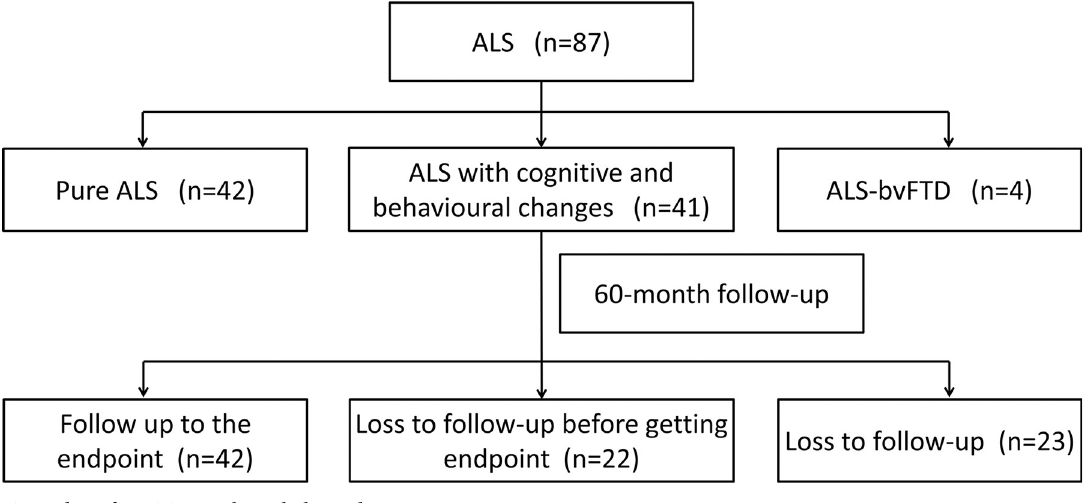
Fig 1. Flow of participants through the